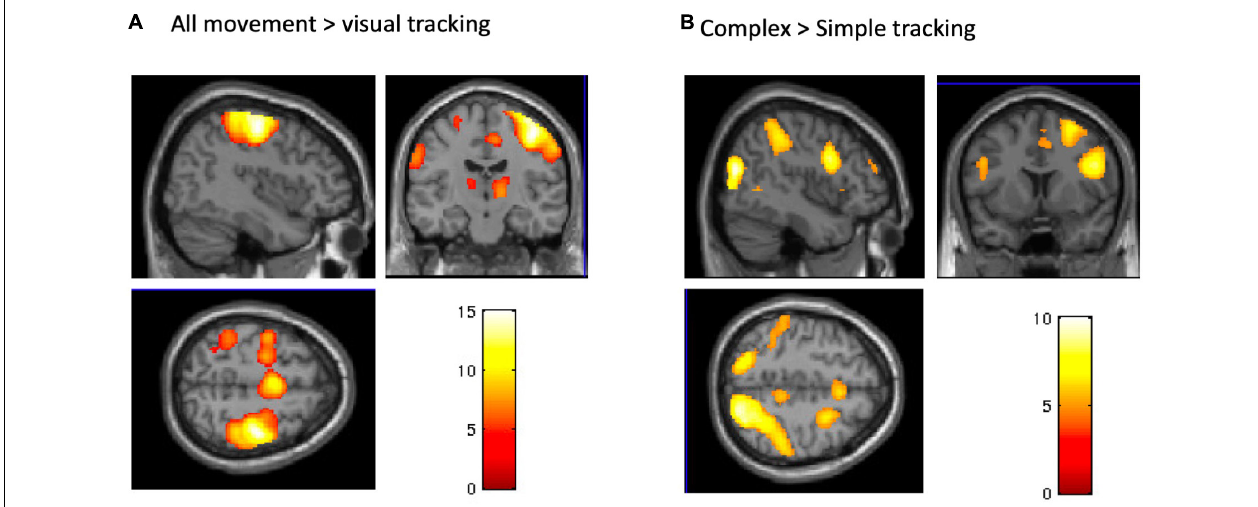
FIGURE 5 | BOLD signals during the tracking task. (A) A conjunction analysis between complex and simple visuomotor tasks. The significant regions were the right precentral gyrus, bilateral SMA, contralateral postcentral gyrus, and IPC and SPL (p < 0.05, FWE). (B) A contrast (complex > simple visuomotor tasks). The significant regions were the right middle occipital gyrus, bilateral SPL, right IPC and premotor cortex, and bilateral SMA (p < 0.05, FWE).